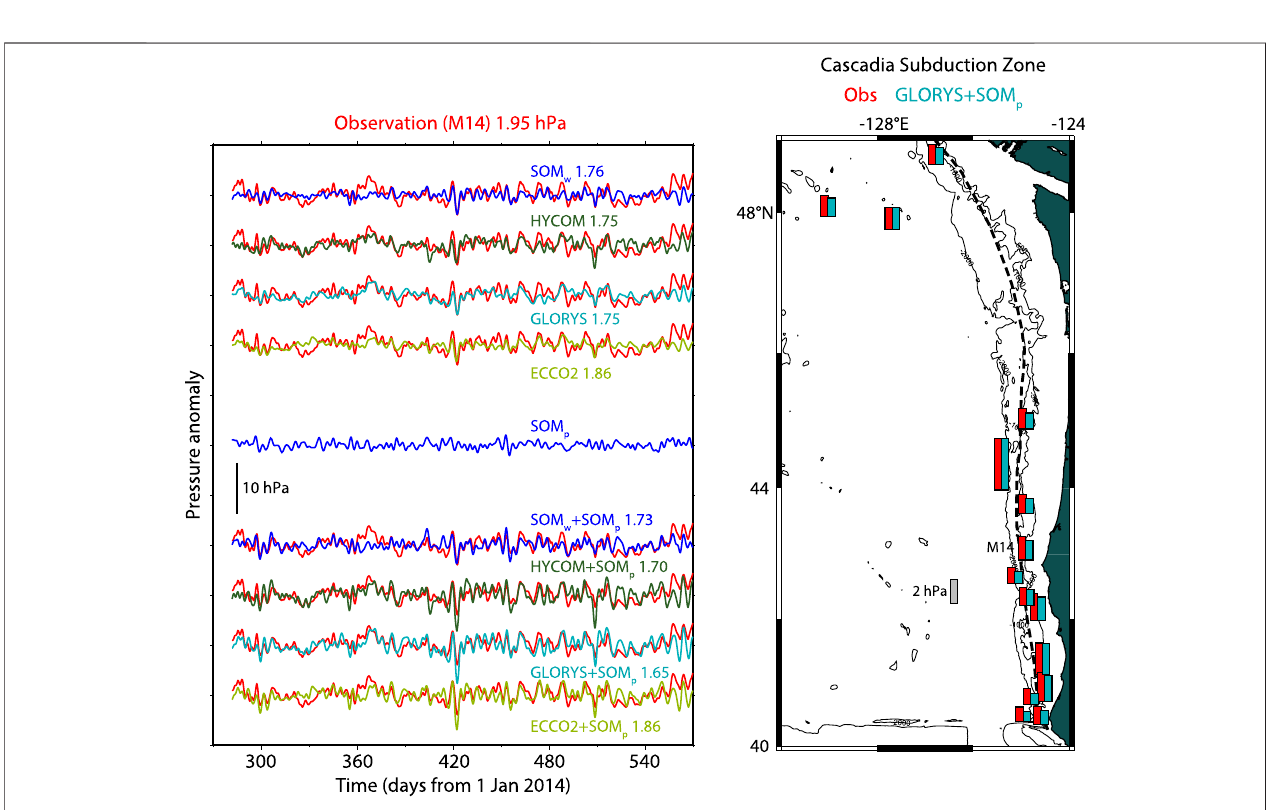
FIGURE 10 | Same as Figure 6 , but for result at M14 at the Cascadia Subduction Zone.